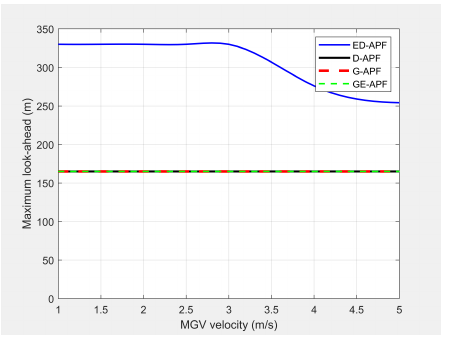
Figure 27. Comparison of the look-ahead distance for different velocities of the MGV.